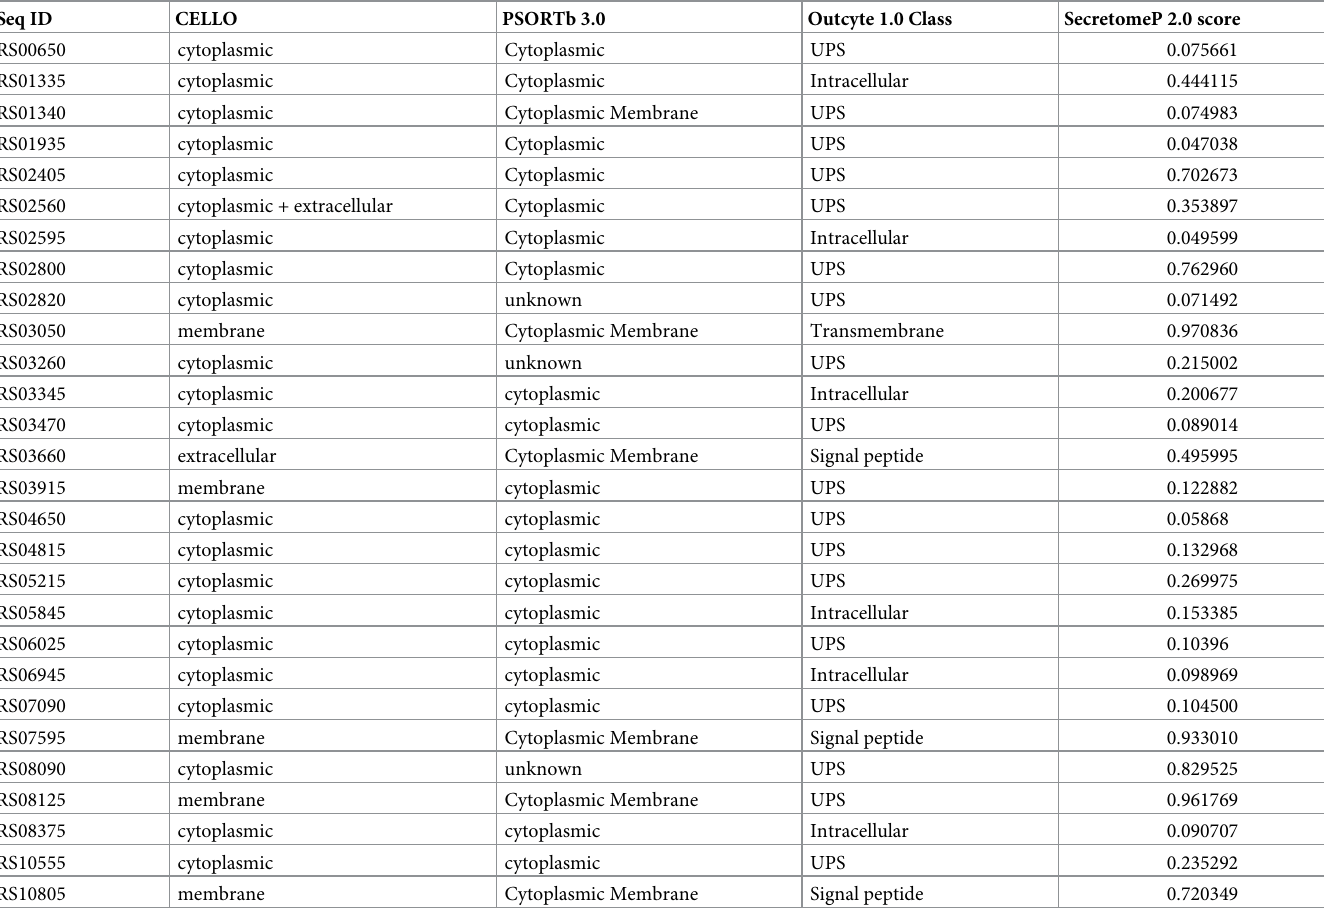
Table 4. Prediction of subcellular localization and unconventional protein secretion in HPs by CELLO, PSORTb, OutCyte 1.0 and SecretomeP 2.0. Seq ID CELLO PSORTb 3.0